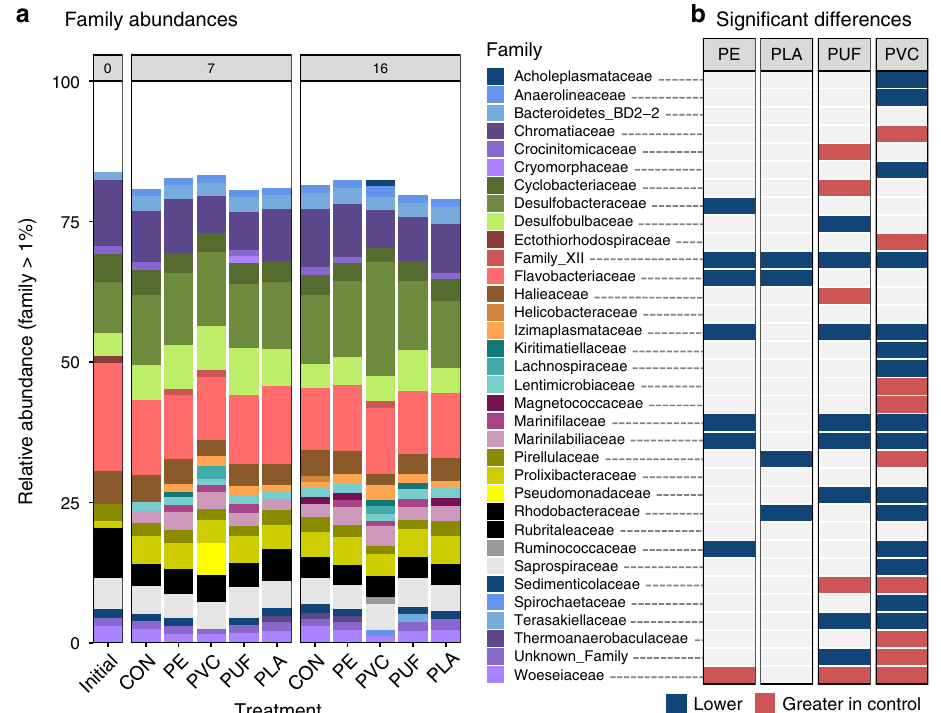
Fig. 3 Bacterial community composition and treatment effects. Comparison of taxonomic differences (family level) in bacterial communities with different microplastic treatments. Stacked bar plot of the relative abundance of families (>1% abundance) for each plastic treatment (averaged for the three replicates, n = 3 per treatment) for each sediment collection date (0, 7, and 16 days), where CON is the control treatment, a. Families that are signi fi cantly different in relative abundance between treatments and controls (averaged across collection dates), determined using DeSeq ( α = 0.01), is illustrated in b, showing if a family is signi fi cantly greater in one of the plastic treatments (blue) or the control (red).